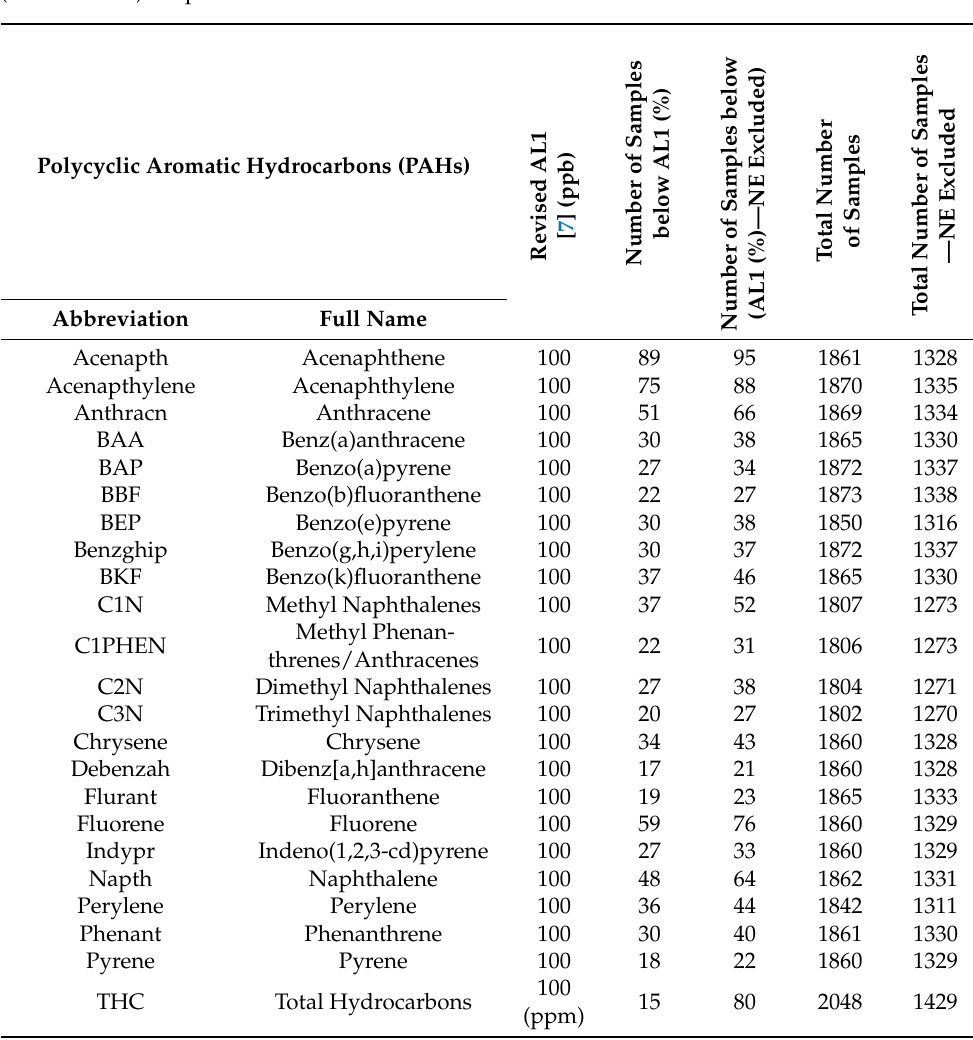
Table 10. Polycyclic Aromatic Hydrocarbons (PAHs)—Revised—Individual PAHs and Total Hydro- carbons (THC). There are no current AL1s, AL2s or revised AL2s. The percentage of samples below AL1 and the percentage of samples below AL1 with the Northumbria and Humber samples excluded (NE excluded) are